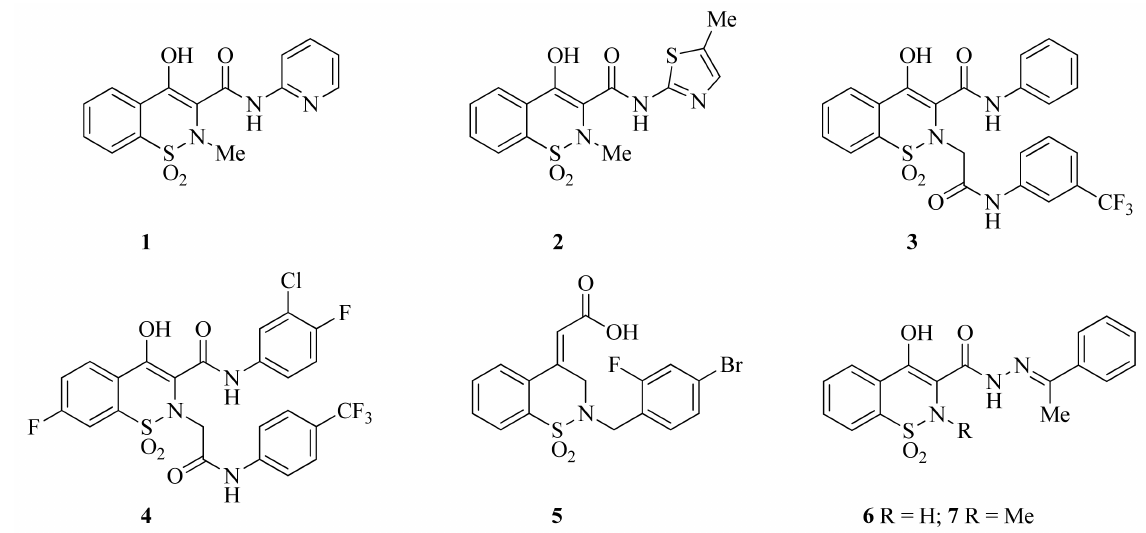
Figure 1. Biologically potent 1,2-benzothiazine 1,1-dioxides. Compound 1 and 2 (antiinflammatory agents), 3 (11 β -HSD1 inhibitor), 4 (SARS-CoV-2 inhibitor), 5 (aldose reductase enzyme inhibitor), 6 and 7 ( α -glucosidase